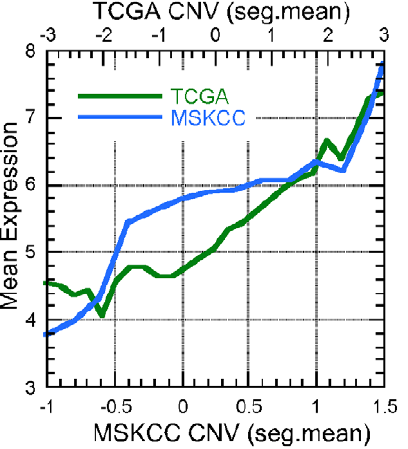
Figure 4. Distribution of gene expression per copy number variation from ovarian cancer tumor cells. As gene copy number variation increases from deletion to amplification the mean gene expression also increases in both the MSKCC (blue line) and TCGA (green line) data sets.